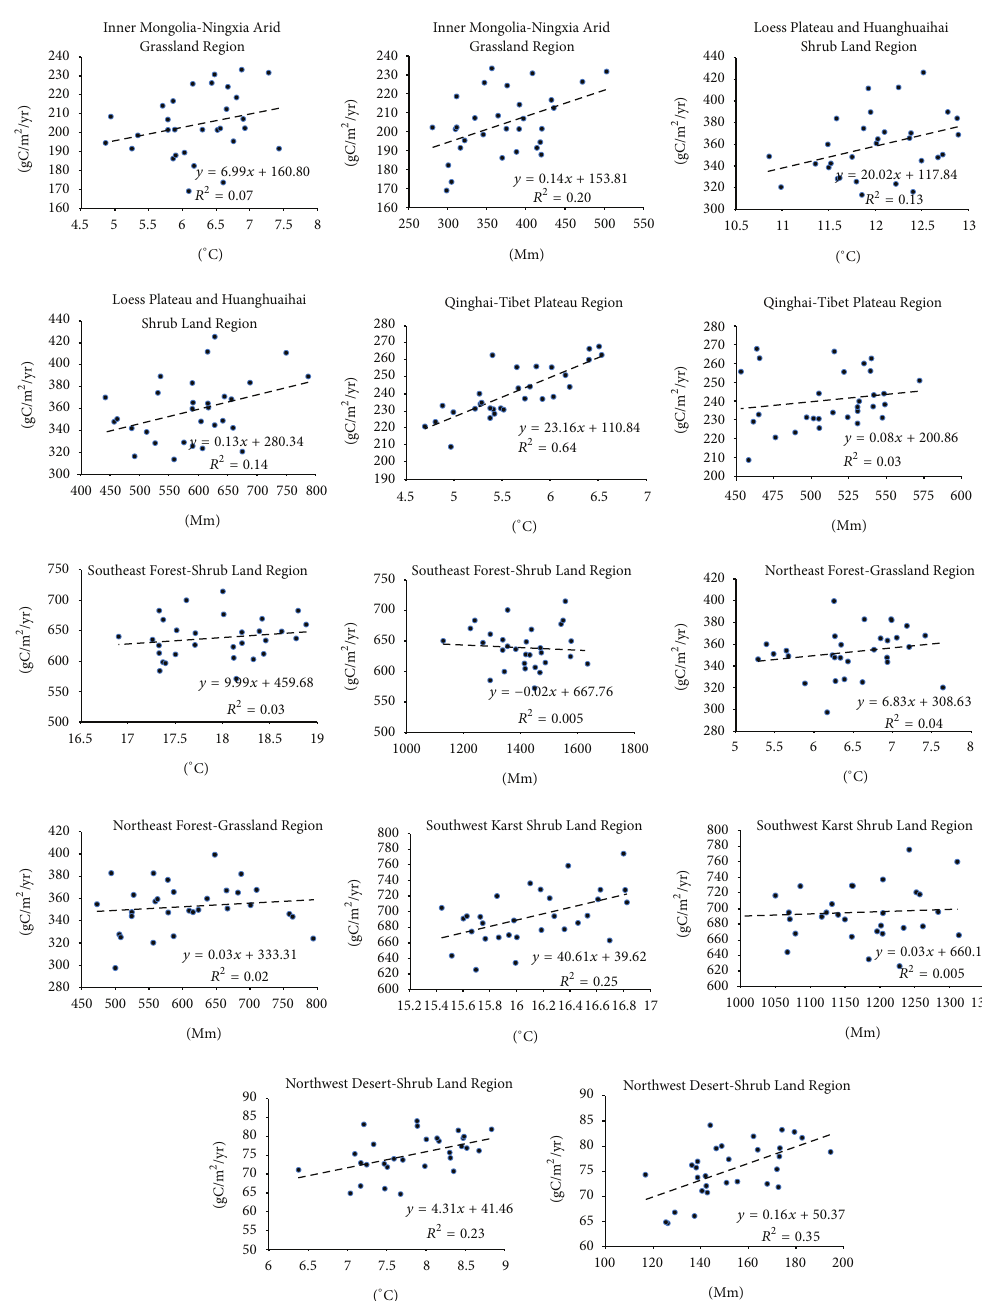
Figure 3: Correlation analysis between the climate index and grassland productivity during 1985–2010 at the grassland ecological-economic zones